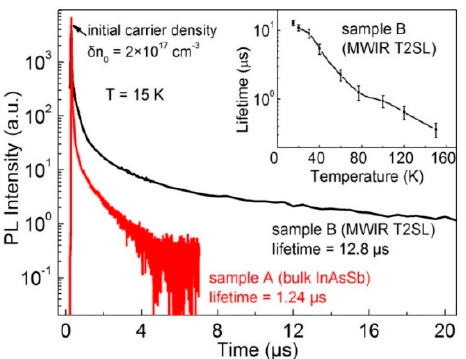
Figure 28. Time-resolved PL decays of samples A (bulk InAsSb) and B (MWIR InAs/InAsSb T2SL) at 15 K. The minority carrier lifetimes of 1.24 μ s and 12.8 μ s are extracted from the single exponential decays, respectively. The inset shows the carrier lifetime of sample B versus temperature (after [104]).